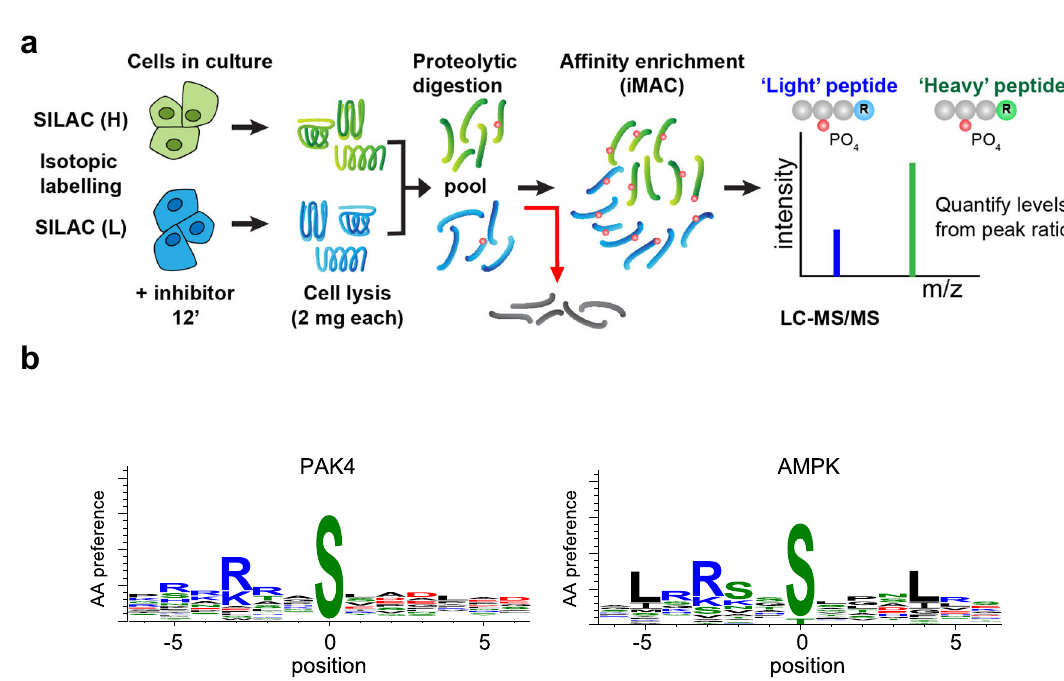
Fig. 6 Analysis of PAK4 proximal substrates by phospho-proteomics. a Schematic of phosphoproteomic analysis to identify phosphorylation sites that are differentially sensitive to PF3758309 versus Frax597. Summary of the work fl ow used to identify phospho-peptides that were depleted following PAK inhibitor treatment (12 min). The p-peptide changes were derived from isotopic ratio extracted from LC-MS/MS spectra. (experiments carried out in ‘ forward ’ and ‘ reverse ’ directions). b A combined matrix for the PAK4 sites was generated using WebLogo 3.7.4. as for a consensus motif for AMPK 113